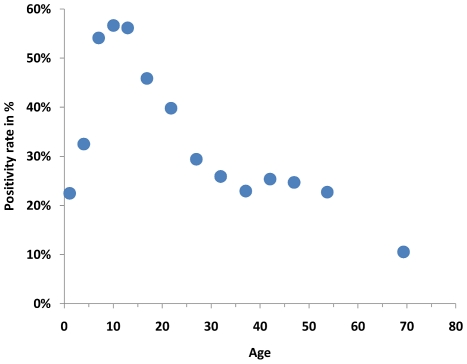
Proportion of positive samples (positivity rate) by age.Points are located at the mean of the ages in the age groups; Germany 2009/2010.